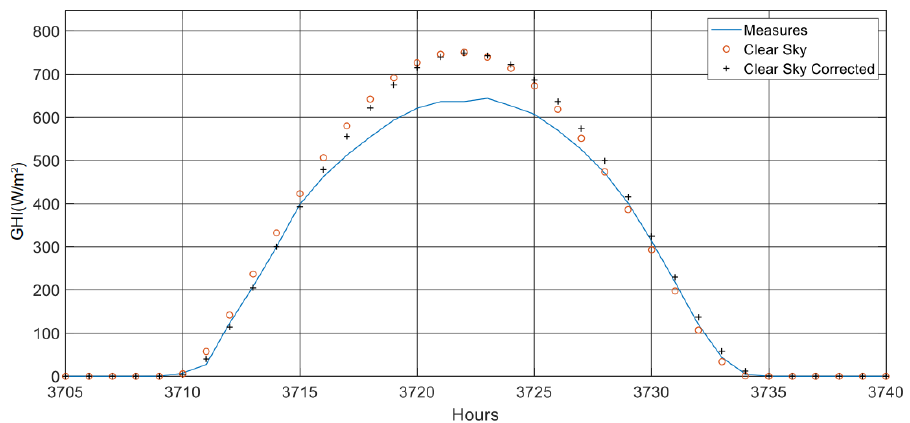
Figure 5. Clear-sky modeling corrected with 20 min offset in A Capela Station (C01) during 2020. Now that the series is correctly recalibrated, we have to check if they are all usable.